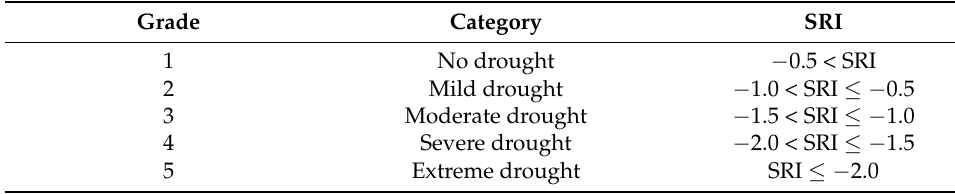
Table 2. Drought grades classified with standardized runoff index.